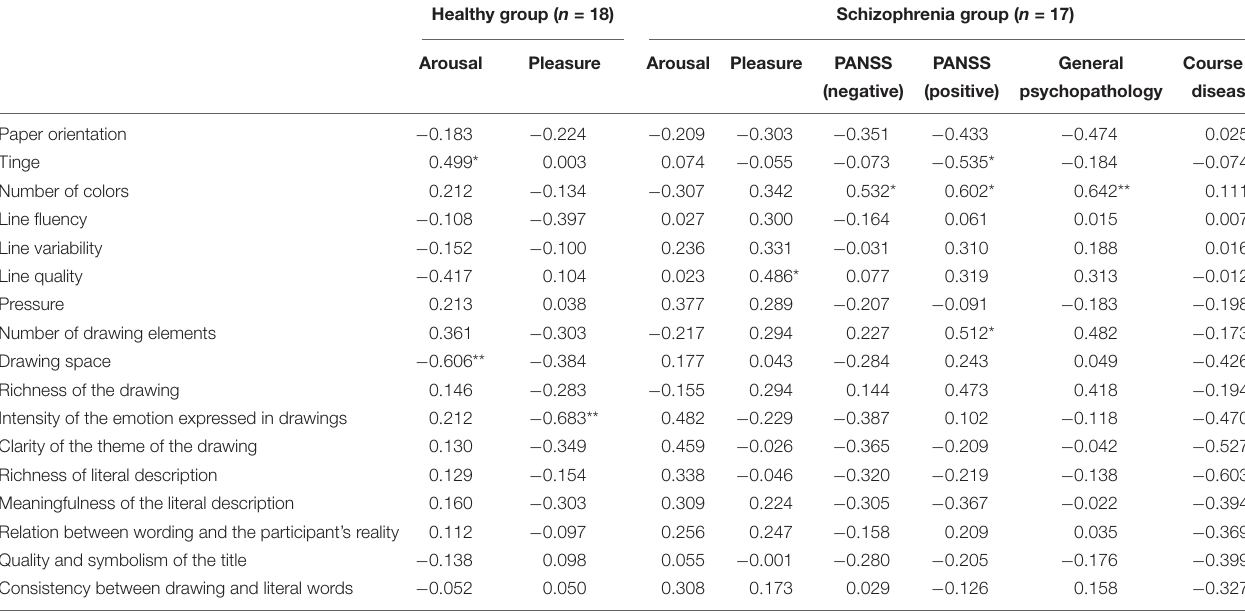
TABLE 9 | Linear correlation coefficients between drawing coding indicators, self-rated arousal and pleasure scores, and disease